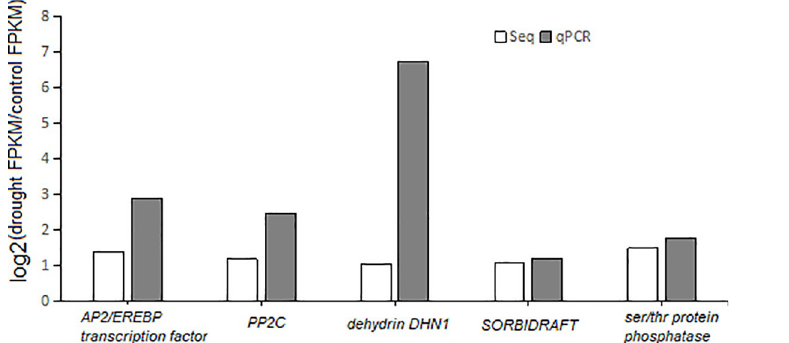
Fig 10. Expression levels of candidate genes in qRT-PCR and